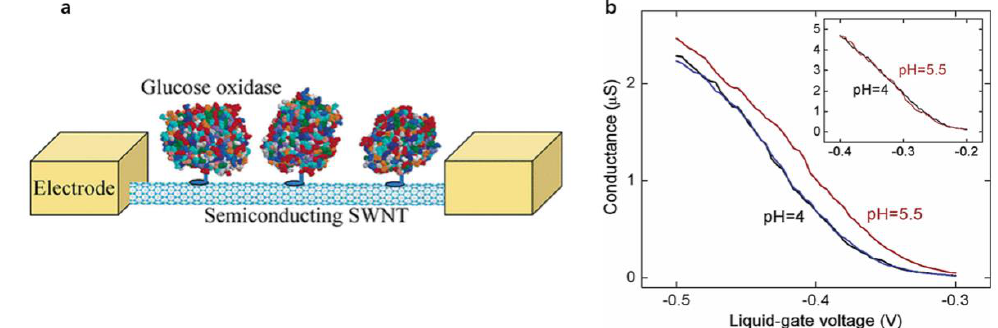
Figure 6. ( a ) semiconductor carbon nanotube device immobilized GOx enzyme; ( b ) the pH sensitivity diagram of the carbon nanotube sensor. At pH = 4.0 ± 0.2 (black line), then at pH = 5.5 ± 0.2 (red line), and finally at pH = 4.0 ± 0.2, the conductance of the semiconductor SWNT fixed by GOx used as the function of the liquid gate voltage (blue line). Reproduced from Koen et al. [145] by permission of the American Chemical Society.